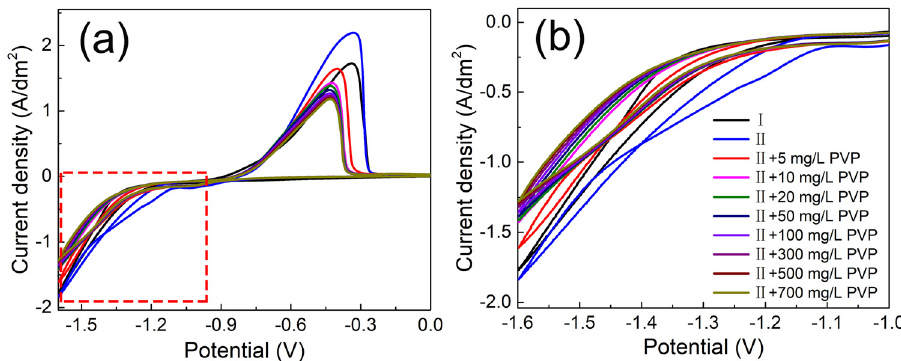
Figure 2: CV plots of cobalt plating solutions ( a and b ) . Panel ( b ) is an enlarged view of the potential in Figure 1a from − 1.6 to − 1.0 V. The solution in this work contains 0.3 mol/L CoSO 4 · 7H 2 O, 0.84 mmol/L CoCl 2 · 6H 2 O, 0.57 mol/L H 3 BO 3 , and 7 mg/L MPS, labeled as solution